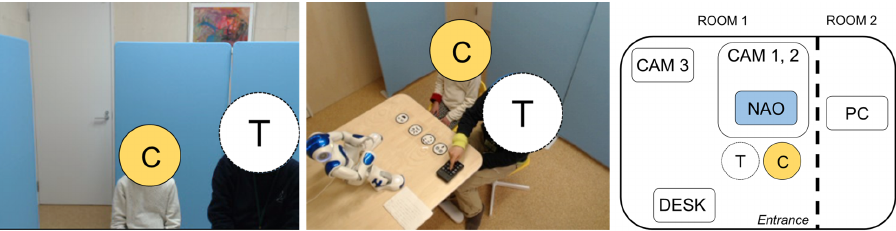
Figure 2. ( Left ) the scene in camera 1, C: child, T: therapist; ( center ) the scene in camera 3, C: child, T: therapist; ( right ) the experiment setup, C: child, T: therapist. At the very beginning of session, child and therapist sit in front of desk for around 10 min to relax before child was exposed to the robot. CAM 1 records only face and upper body of the participants. CAM 2 is used for recognizing the facial expressions. CAM 3 records the whole scene of session for reference.